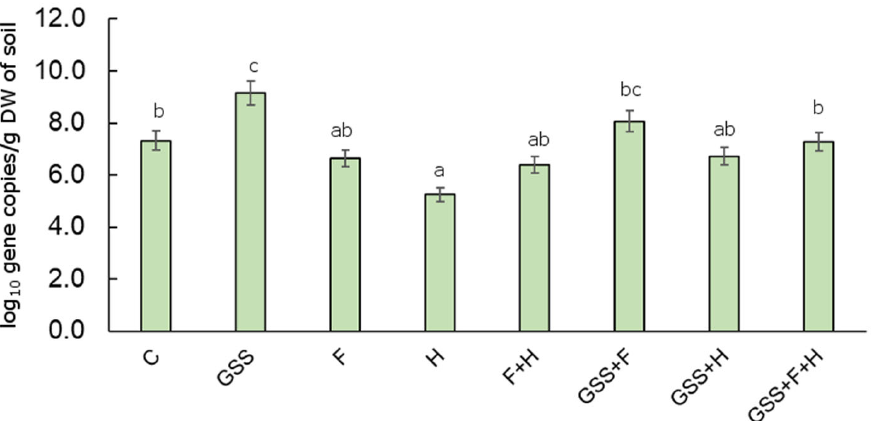
Figure 5. The abundance of amo A gene copy number (log 10 gene copy numbers/g DW of soil) in the soil samples collected for experimental plots. The data are presented as means ± SD; the same letters mean non ‐ significant differences between treatments assessed by Tukey post hoc HSD test at p < 0.05.